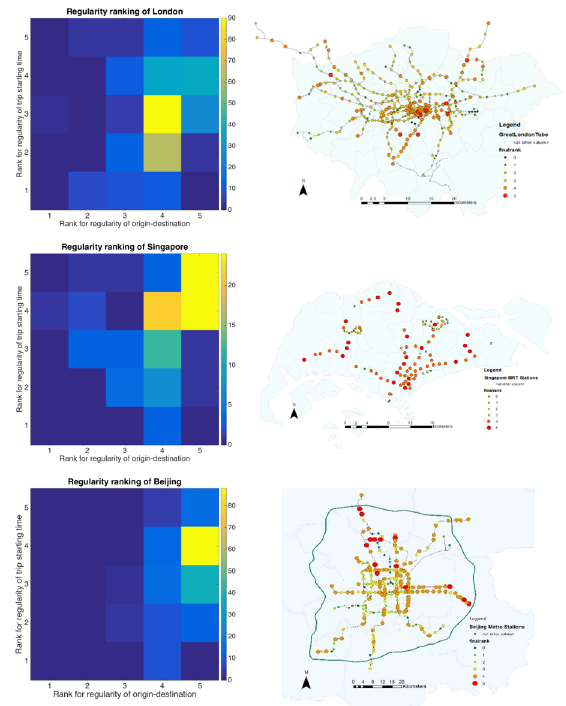
Fig 8. Combined ranking of when and where people travel. Note: Stations are ranked by CVar cutoff = 0.1 and measured using temporal scales = 4, 15, 30, 60 and 180 (minutes). Stations which fulfill conditions at 4 minute temporal scales get the highest rank as 5 and so on. The geographic mapping is color coded by a combined